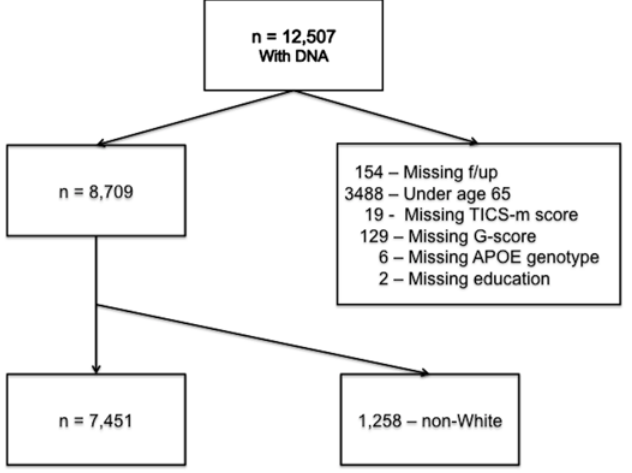
Fig 1. Sample Selection Flowchart. Abbreviations: f/up: follow-up; TICS-m: Telephone Interview for Cognitive Status-modified; G-score: genetic risk score.